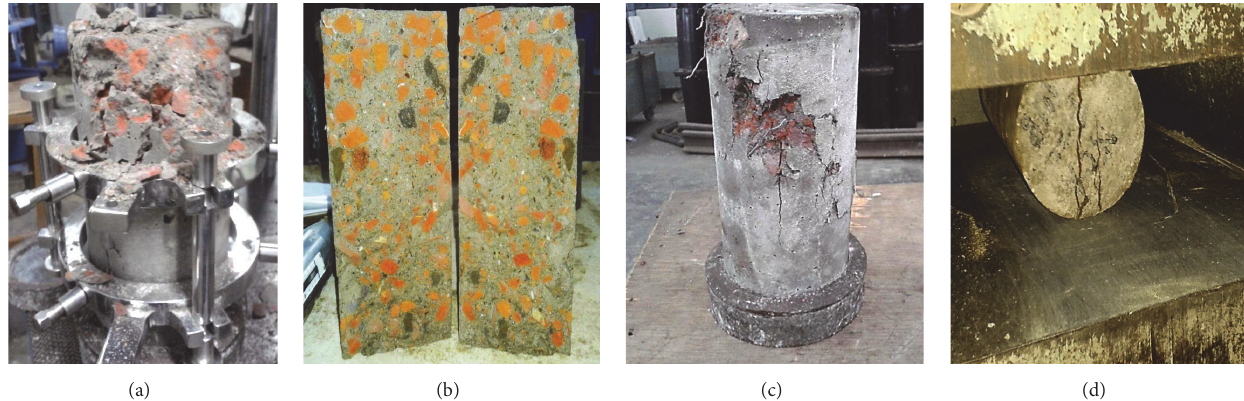
Figure 14: Failure surfaces of cylinder (a & b) compression and tensile splitting test of plain concrete (c & d) compression & tensile splitting test of SFRC.